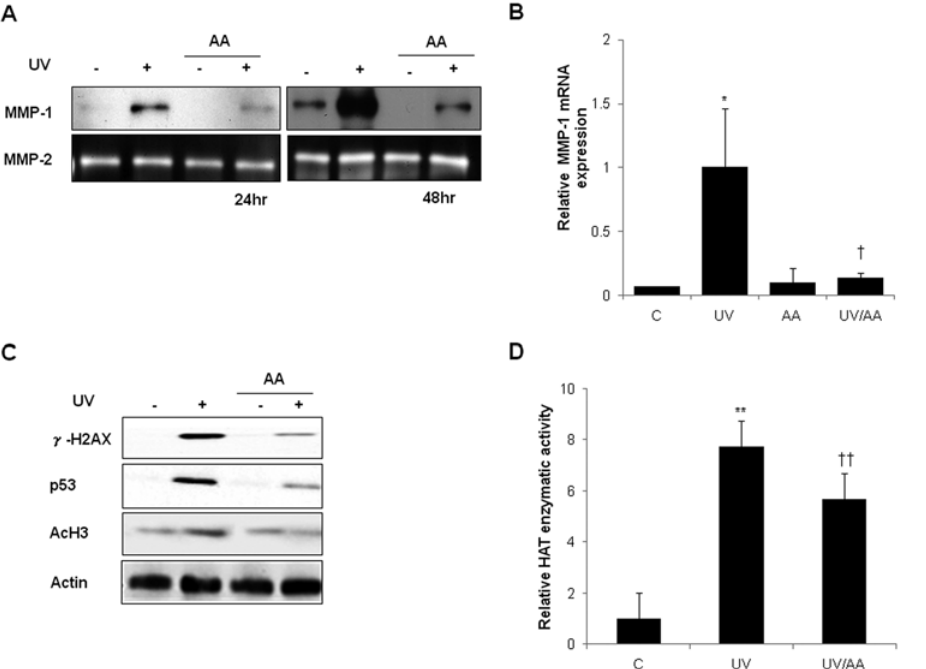
Figure 3. AA suppressed UV-induced MMP-1 expression and inhibited UV-enhanced levels of c -H2AX, p53, and acetyl-H3. A, HDFs were incubated with AA for 24 h or 48 h after UV radiation and MMP-1 expression was analyzed by western blot. MMP-2 protein levels were analyzed by zymography. B, Level of MMP-1 mRNA was quantified by real-time RT-PCR and was normalized to the respective 36B4 mRNA levels. C, 6 h after 150 mJ/cm 2 irradiation, HDFs with or without AA treatment were examined by western blot for c -H2AX, p53 and acetyl-H3. D, HAT activity of nuclear lysates was determined in HDFs with or without AA treatment after UV-irradiation through an indirect ELISA that detects acetyl residues. C: control, UV: UV-irradiated cells, AA: AA treated cells, UV/AA: UV irradiated cells incubated with AA. *P , 0.05, **P , 0.01 vs. control; { P , 0.05, { { P , 0.01 vs.